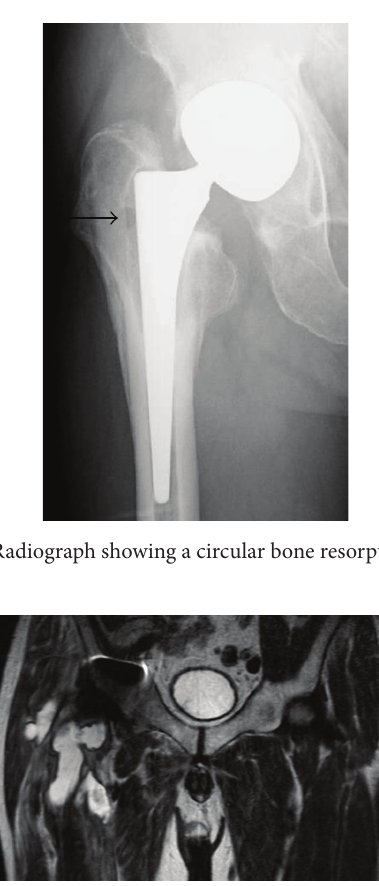
Figure 2: T2-weighted image showing a high intensity lesion with partial low signal intensity, which extends from the lateral aspect of the greater trochanter to the anterior intermuscle of the thigh.